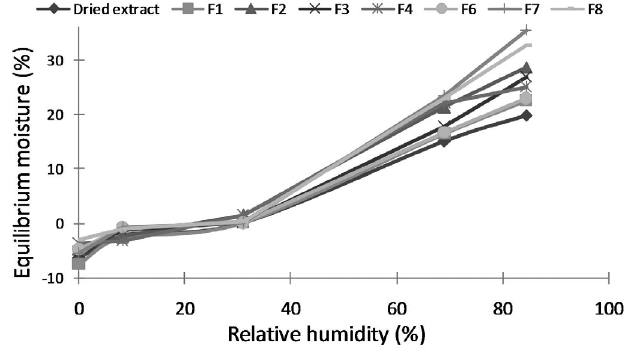
FIGURE 5 - Sorption isotherms of Maytenus ilicifolia dried extract and formulations of effervescent granules (F1, F2, F3, F4, F5, F6, F7 and F8) obtained from the factorial